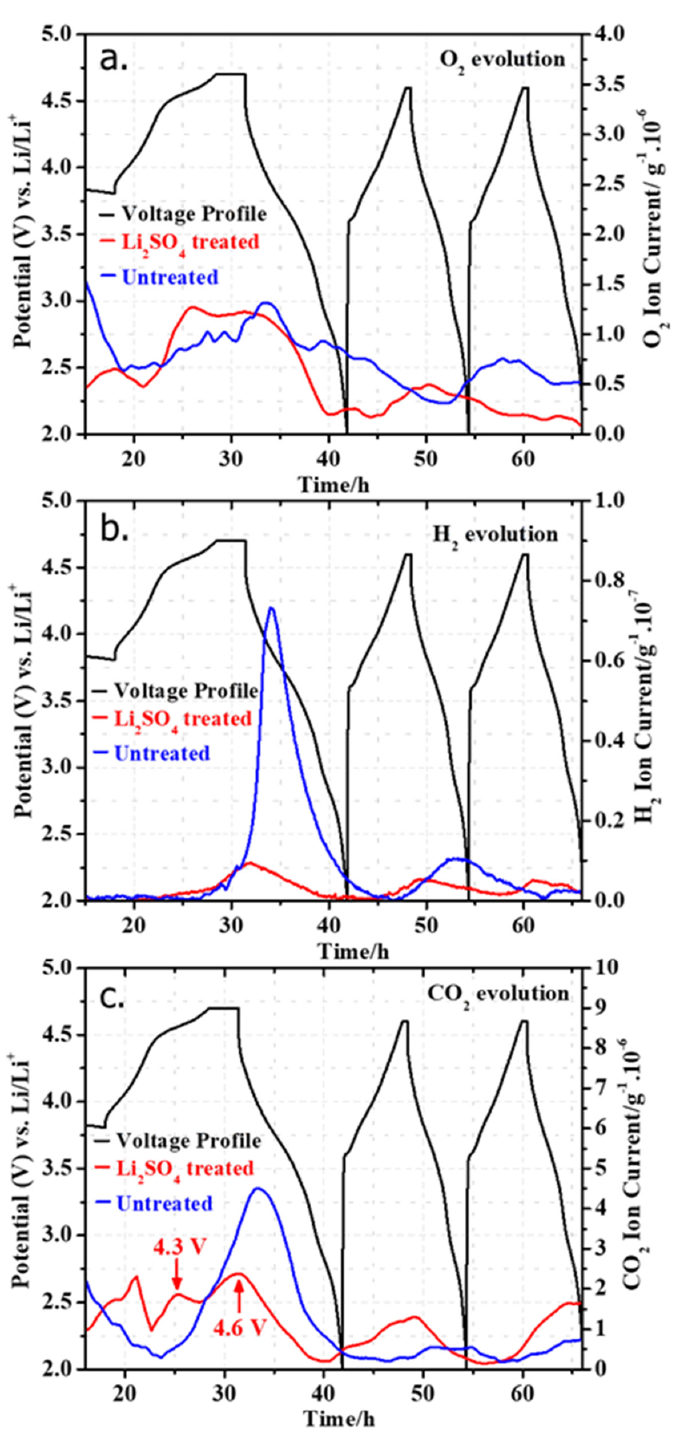
Figure 11. Results of the online mass spectrometry studies during cycling of electrodes comprising untreated HE-NCM (blue) and Li 2 SO 4 treated materials (red), showing the evolution of ( a ) O 2 , ( b ) H 2 , and ( c ) CO 2 . These measurements were performed in half-cells with Li-foil anodes and 1.0 M LiPF 6 /EC-EMC (3:7 v / v ) electrolyte solutions (LP57).